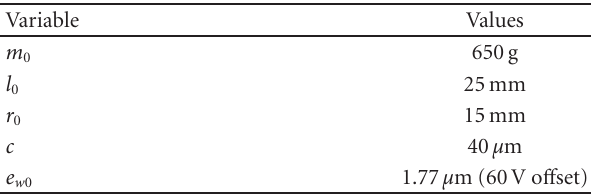
Table 1: Dimensions of test